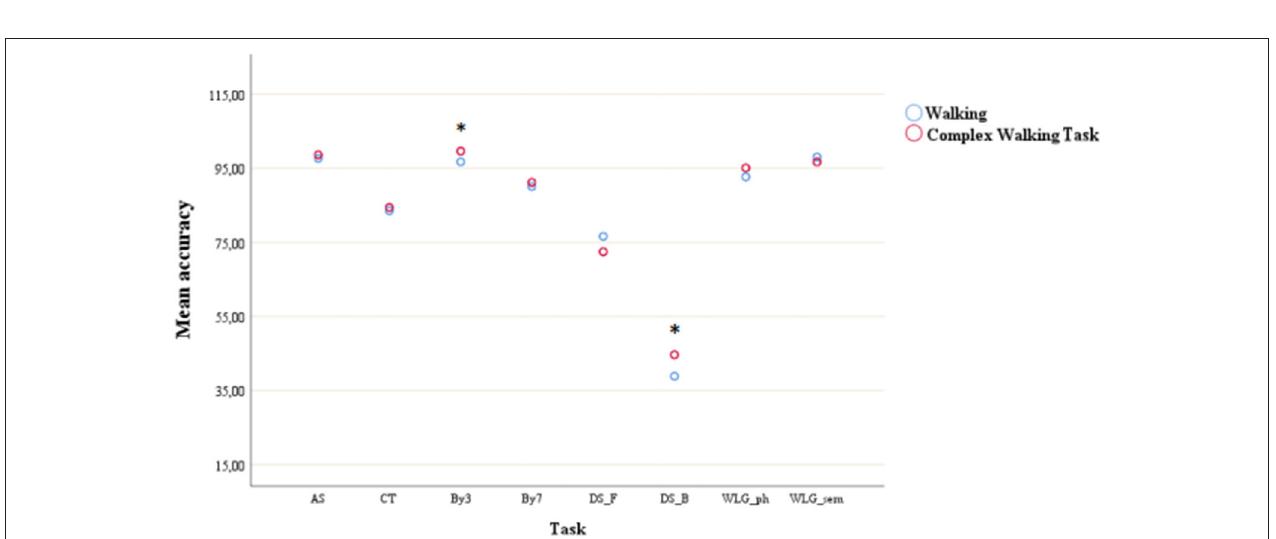
FIGURE 3 | Mean accuracy during simple walking and complex walking task across cognitive tasks. * post-hoc test showed significant difference with all the other tasks. AS, auditory stroop; CT, clock test; by3, subtracting by3; by7, subtracting by7; DS_F, digit span forwards; DS_B, digit span bacwards; WLG_ph, word list generation phonemic; WLG_sem, world list generation